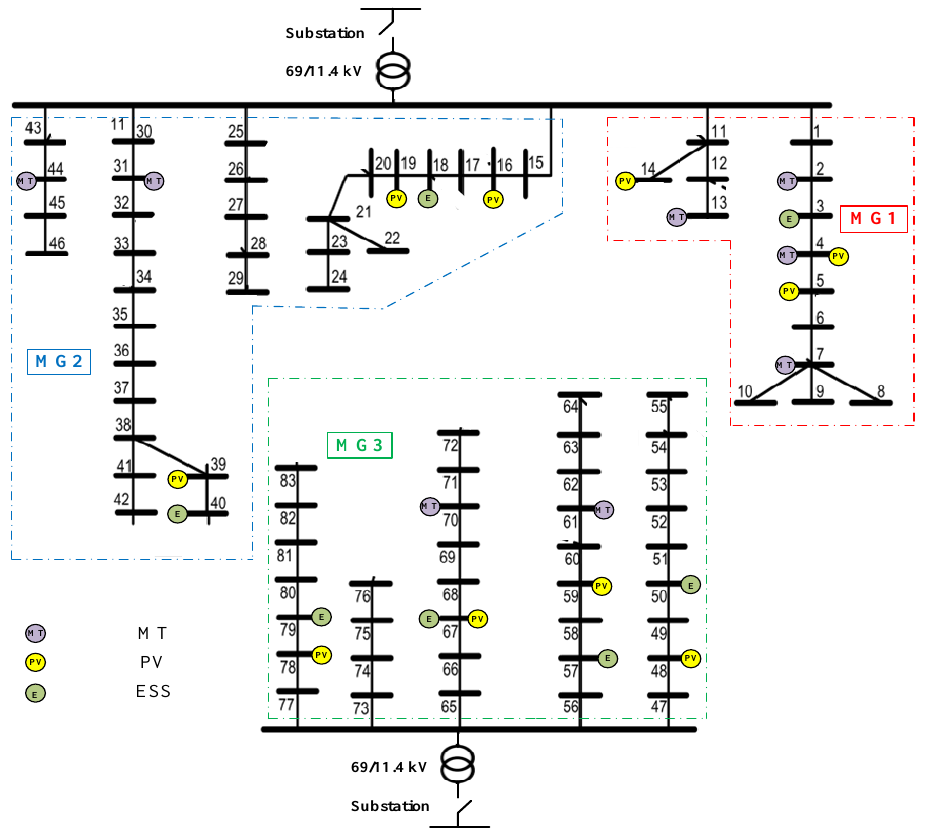
Figure 3. The 84-bus Taiwan Power Company (TPC) distribution test system [1].